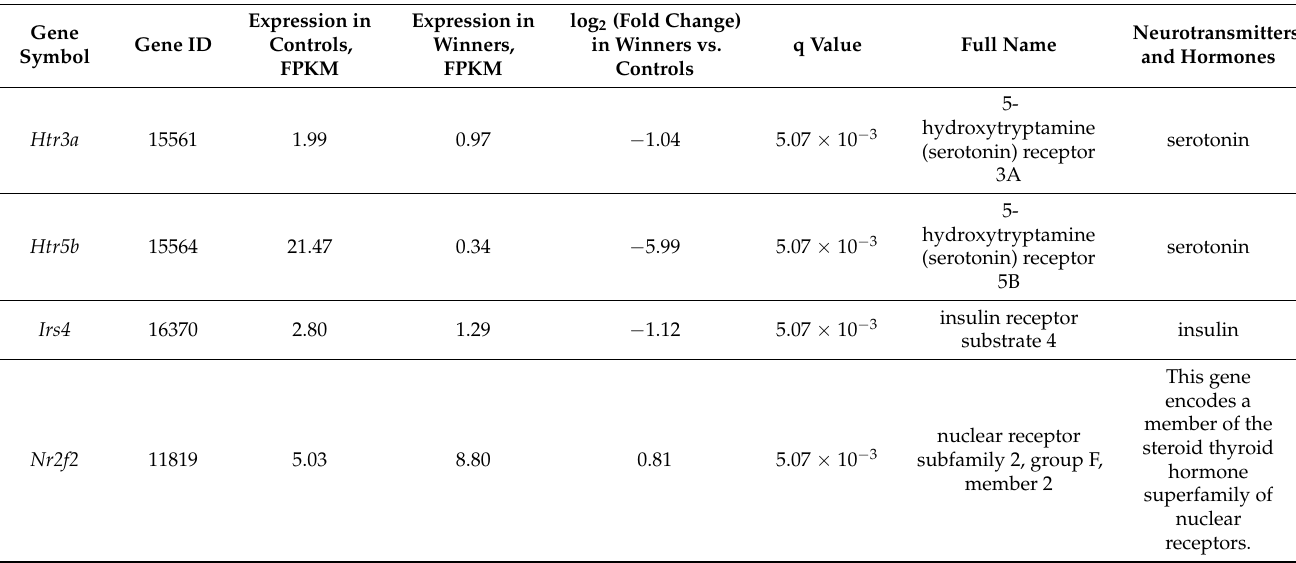
Table 4. Cont. DEGs Encoding Receptors for Neurotransmitters and Hormones in the MRNs of Winners versus Control Mice